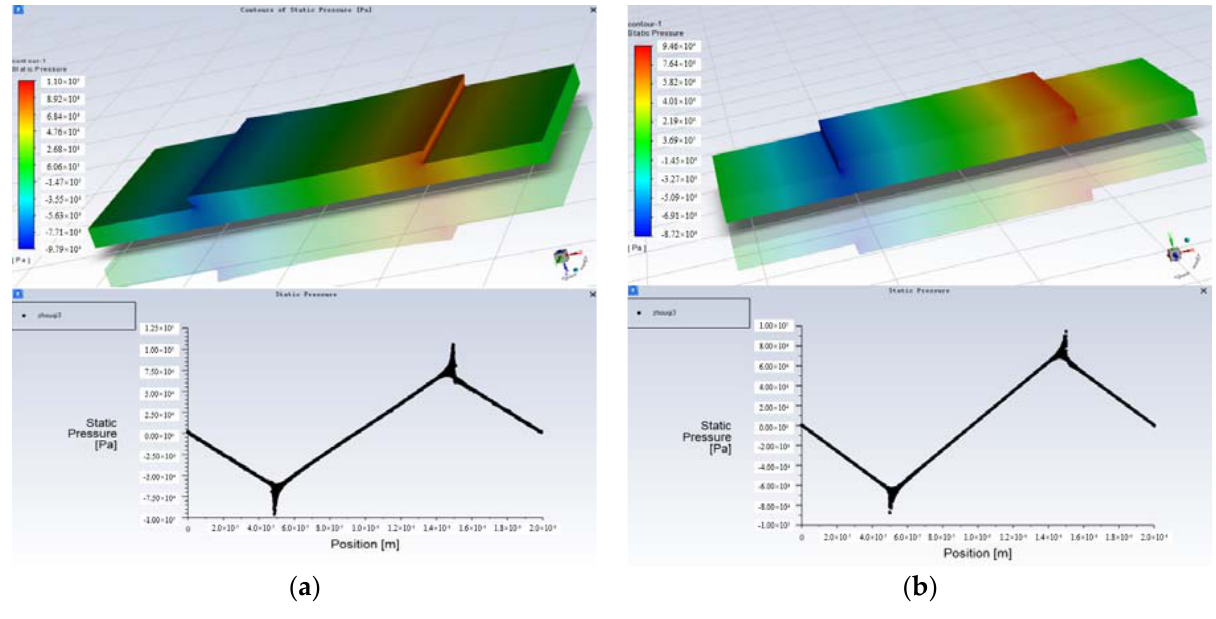
Figure 6. The stress distribution cloud map and pressure distribution curve of the oil film when the texture area ratio is 50%. ( a ) The overall stress distribution cloud diagram and the pressure distribution curve on the section when the sealing material is PFFE; ( b ) The overall stress distribution cloud diagram and the pressure distribution curve on the section when the sealing material is set as a rigid body .